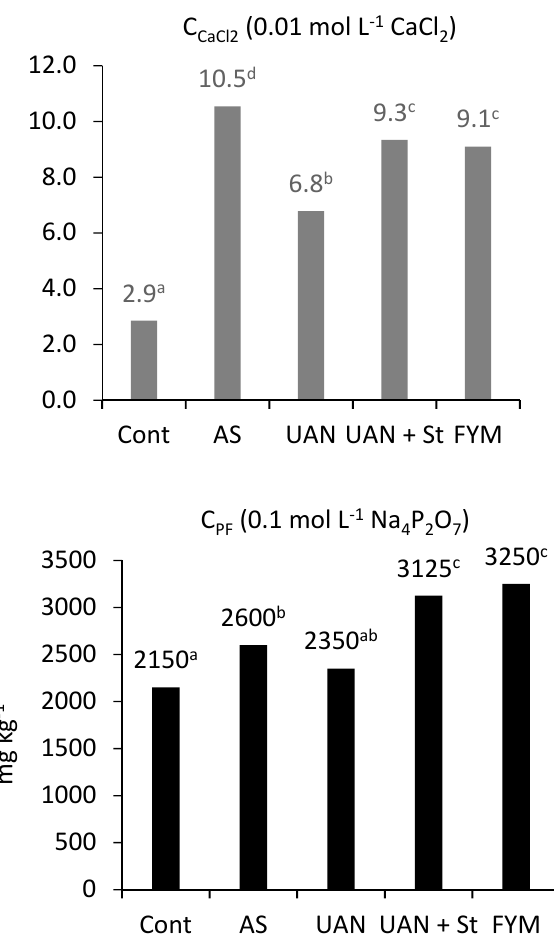
Figure 4. Content of extractable carbon determined with different extraction procedures; topsoil; different letters behind the values mean significant differences among investigated treatments (Tukey test; p < 0.05); number of replications per treatment n = 4.